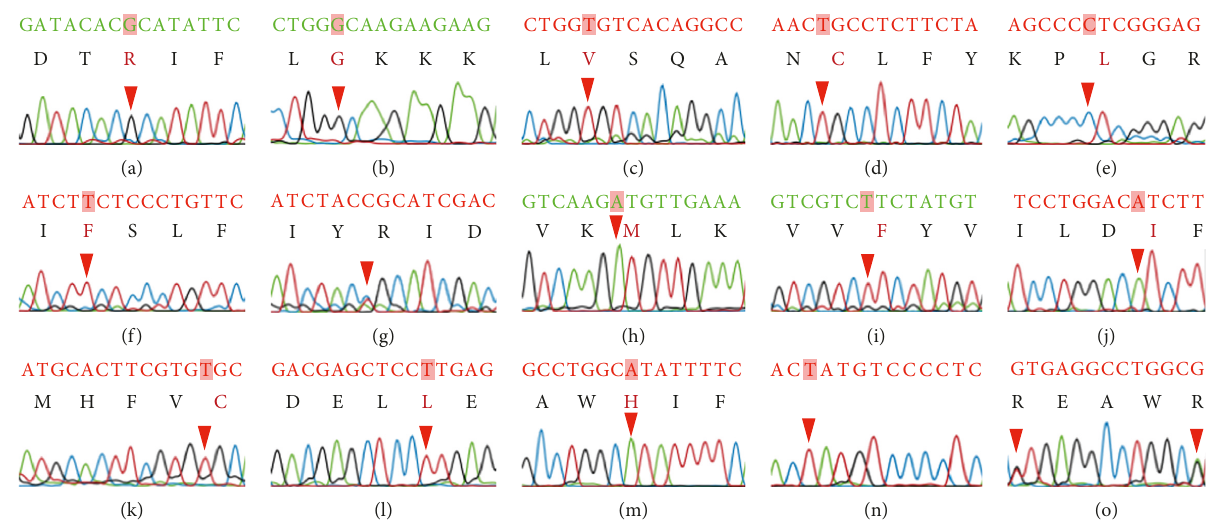
Figure 3: The electropherogram of G6PD variants. (a) Gaohe (c) 95A